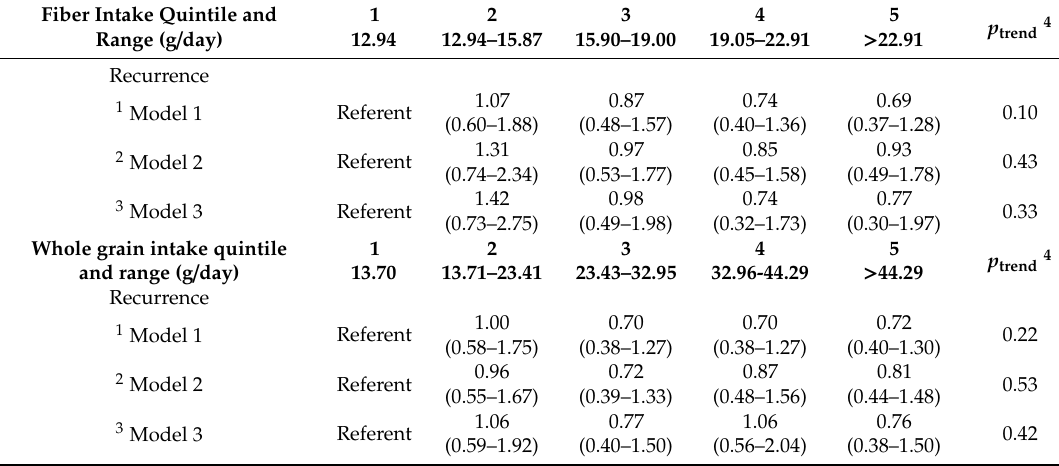
Table5. Multivariablehazardratiosandtheir95%confidenceintervalsofrecurrenceriskbypretreatment total dietary fiber or whole grain consumption